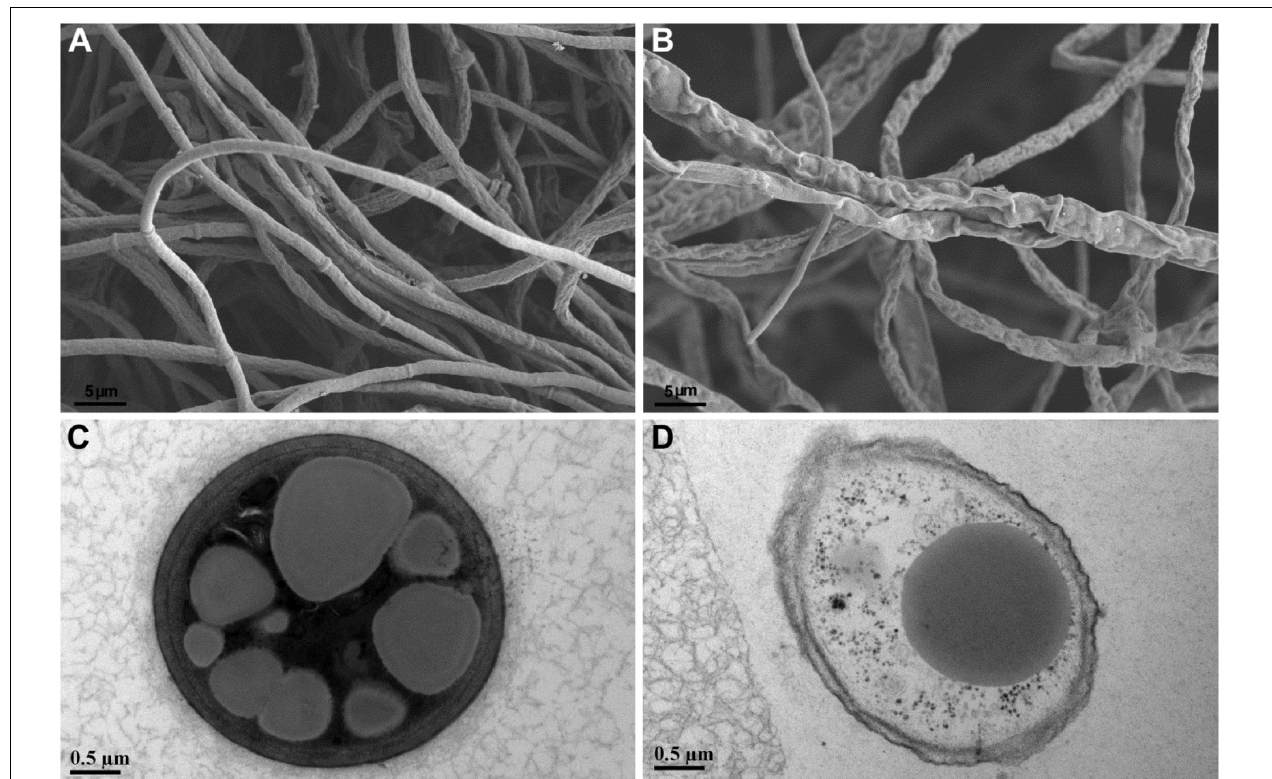
FIGURE 4 | Structures of Fusarium graminearum hypha shown by scanning electron microscopy (A,B) and transmission electron microscopy (C,D) . Control hyphal cell walls are smooth (A) and intact and contain electron-dense cell contents and relatively electron-lucent lipid granules (C) . Hypha confronting Paenibacillus peoriae strain RP51 are shrunk and distorted (B) ; incompletely developed cell walls are broken and in association with cellular vacuolization (D)